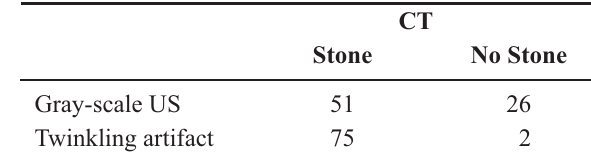
Table 3 – Comparison of urinary stone detection with gray- scale ultrasound (US) and Doppler twinkling